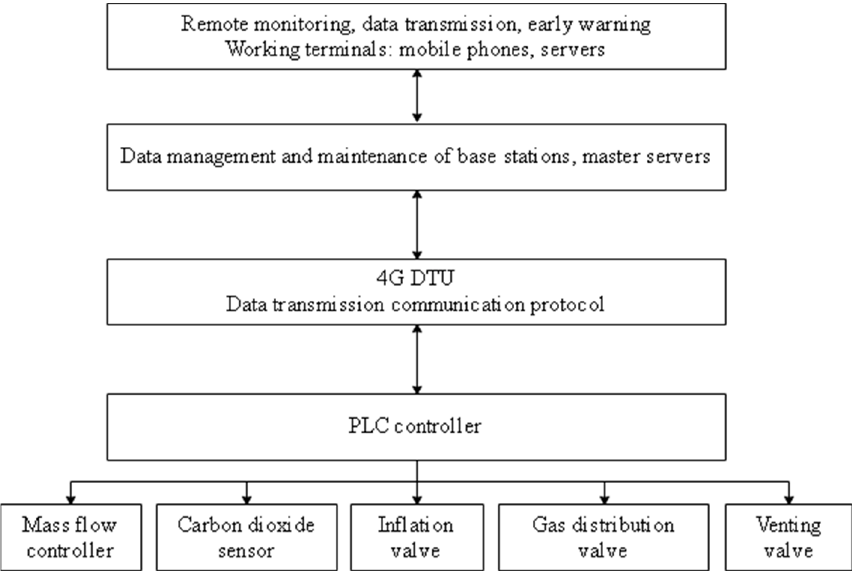
Figure 3. Data transmission and architecture diagram of the gas distribution system.